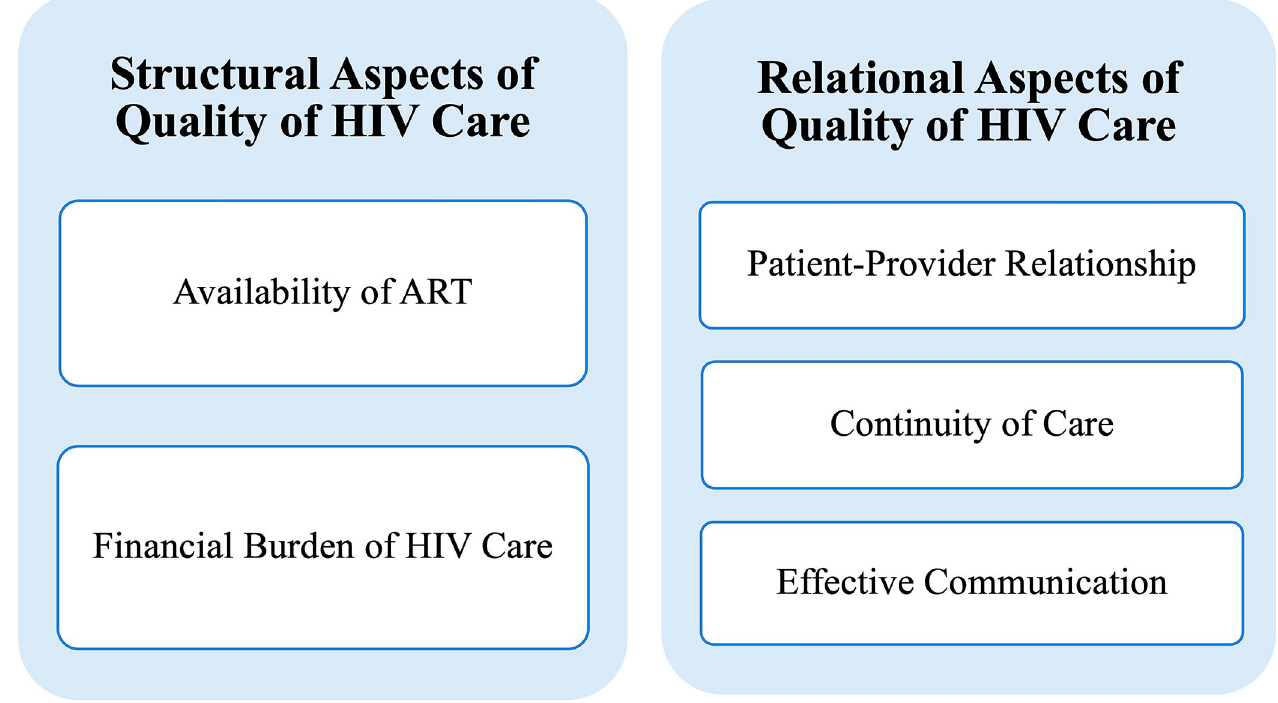
Fig 1. Salient themes related to the context and dynamics of quality of HIV care organized by structural and relational domains.